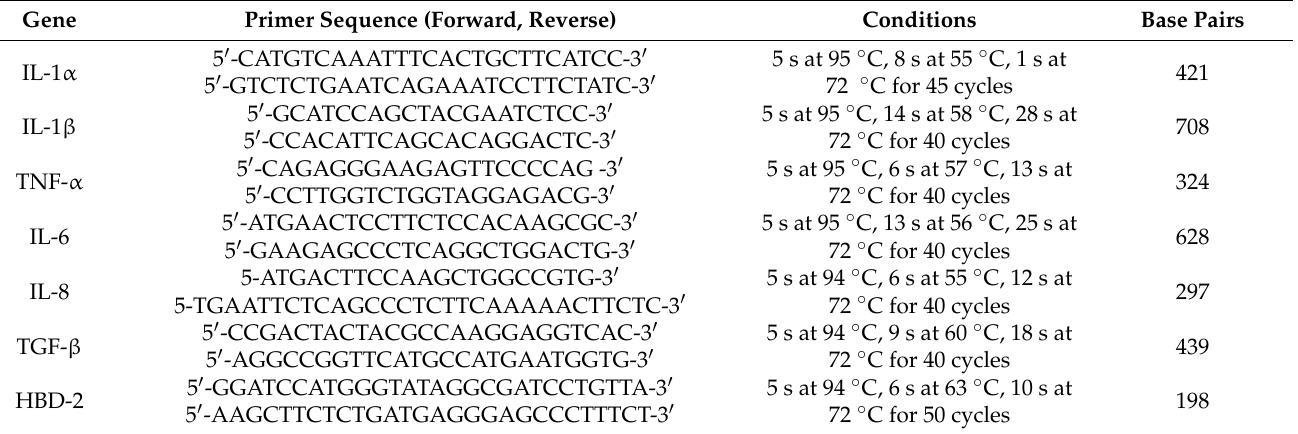
Table 2. Analyzed genes involved in the immune response of HaCaT cells exposed to CN-coated cellulosic tissues. Gene Primer Sequence (Forward, Reverse) Conditions Base